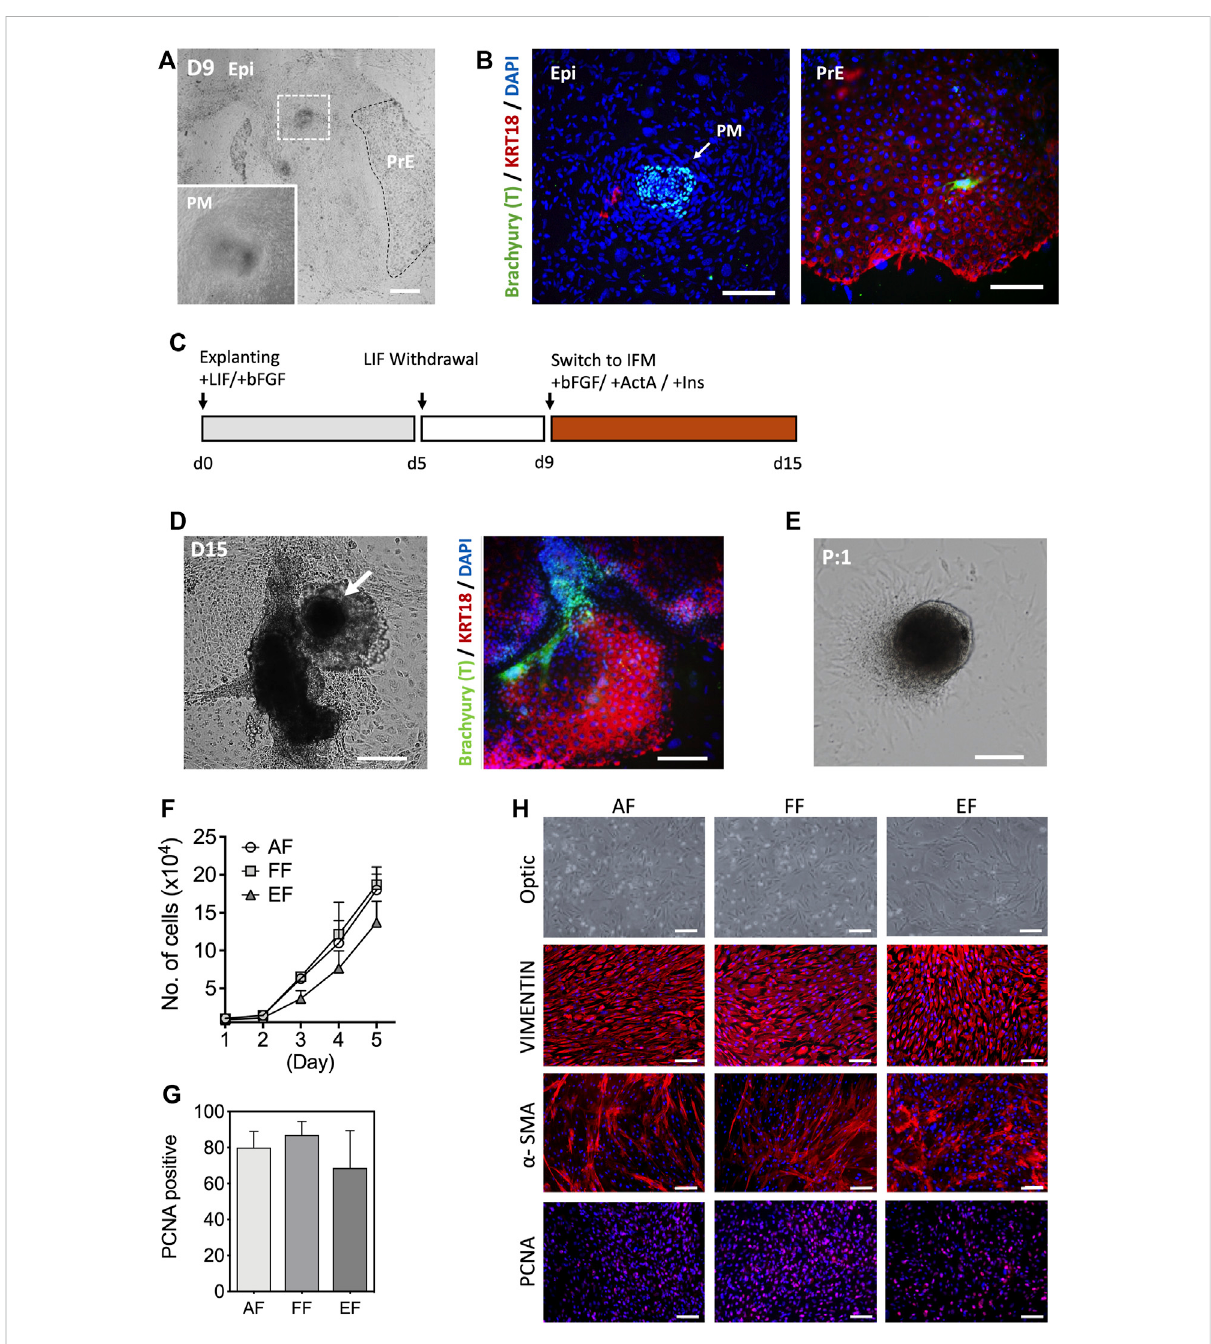
FIGURE 1 Characterization of embryonic fi broblasts (EF) derived from blastocyst outgrowths. (A) Representative images of d9 primary blastocyst outgrowth. Differentiated cell aggregates appear in outgrowths following explanting blastocysts in culture (white dotted, inlet). (B) Immuno fl uorescence staining indicated that the differentiated cell clusters were positive for a mesenchymal marker Brachyury (T; arrow), but negative for epithelial KRT18 after 9 days of differentiation in the hLIF withdrawal medium. (C) Schematic of the differentiation protocol. (D) Morphological appearance of differentiated cells and immuno fl uorescence staining of T and KRT18 in d15 primary blastocyst outgrowths. (E) The population of spindle-shaped cells grew from the edges of explants following subculture. (F) Cell growth curves for the three fi broblast groups: fi ve AFs from a neonatal ear biopsy, fi ve FFs from day 28 – 50 fetuses, and six EFs from day 7 blastocysts fertilized in vitro . Ten thousand cells (passage 3) were used for the experiment (n = 3). (G) The mean number of PCNA positive nuclei. In this study, the fetal fi broblast cells displayed higher PCNA positivity than the adult and embryonic fi broblasts, but there were no statistical differences in the number of PCNA positive cells (ANOVA, p < 0.05). (H) Representative immunostaining images of VIMENTIN, α -SMA, and PCNA marker expression in three fi broblasts. EPI, epiblast, PM, primary mesenchyme, PrE, primitive endoderm. Data is presented as the mean ± SD. Bar, 100